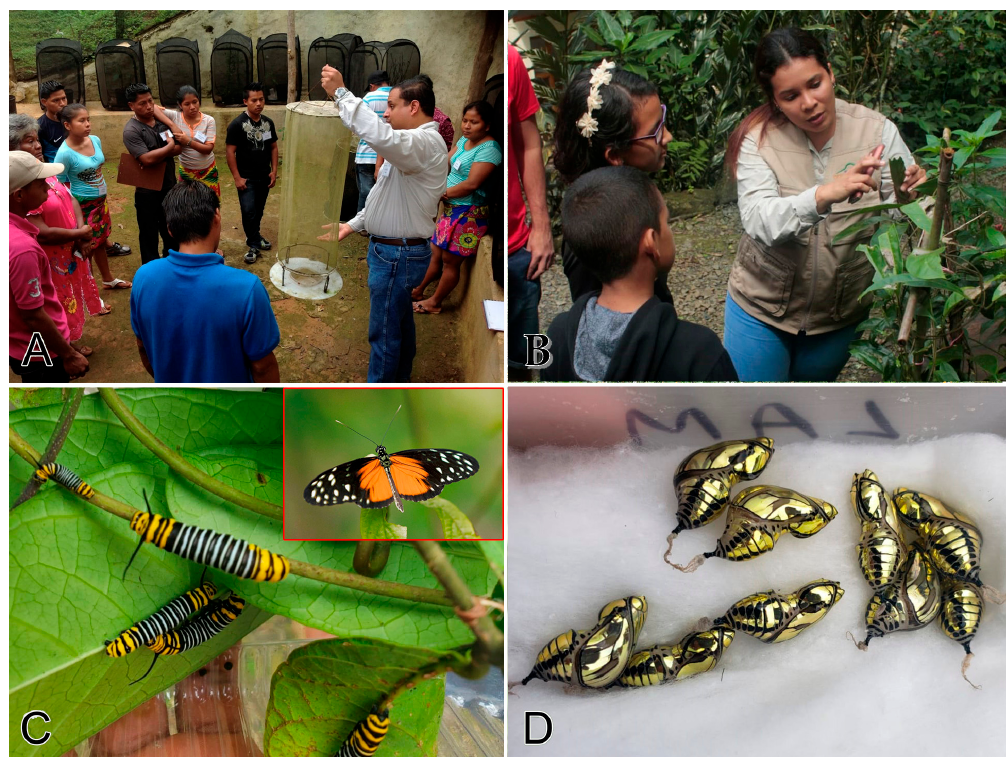
Figure 4. Scenes of Mariposario Cerro La Vieja (Butterfly Farm) in Panama. ( A ): Samuel Vald é s, owner of the Mariposario Cerro La Vieja (Butterfly Farm), Panama, conducting a training in butterfly ranching methods; ( B ): Marelys Torres, co-owner of the Mariposario Cerro La Vieja, explaining butterfly life cycles to local students; ( C ): Larvae of Tithorea tarricina (Ithominae) feeding on host plant Prestonia portobellensis (Apoacynaceae), with an perching adult in the red box; ( D ): Pupae of T. tarricina (Ithominae) packed for shipment to Panama